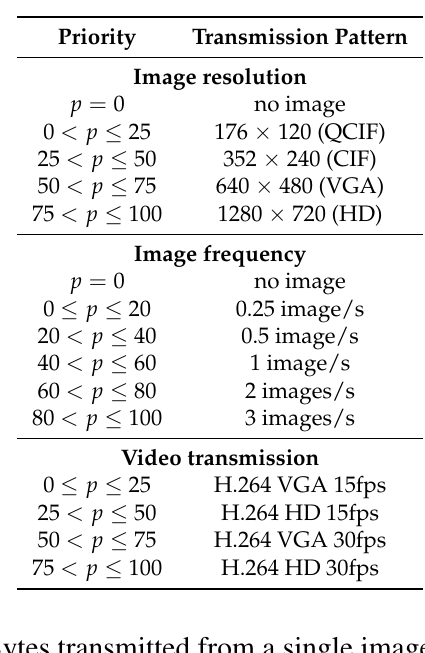
Table 3. SmartCitySensing approach.